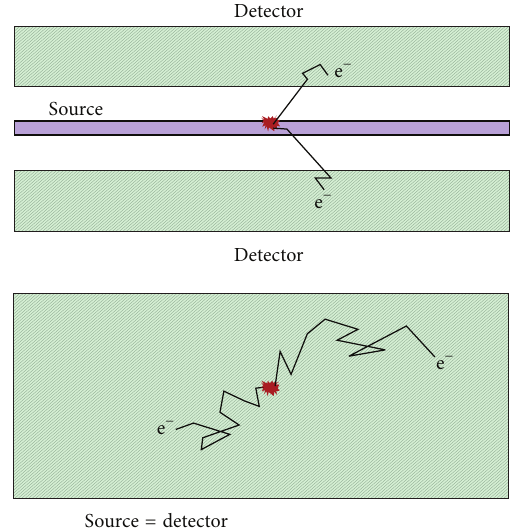
Figure 16: Schematic representation of the two main experimental categories for the 0 ] 𝛽𝛽 search: calorimetric technique (source ≡ detector) and external source approach (source ̸=